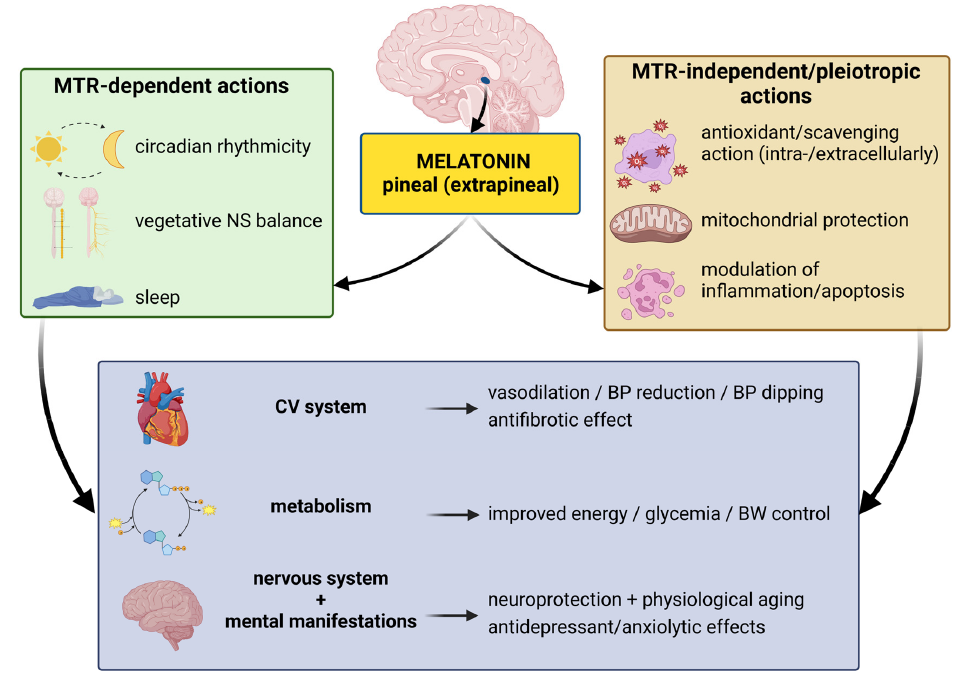
Figure 3. Receptor-dependent and receptor-independent effects of melatonin. MTR, melatonin receptor; CV system, cardiovascular system; BP, blood pressure; BW, body weight.